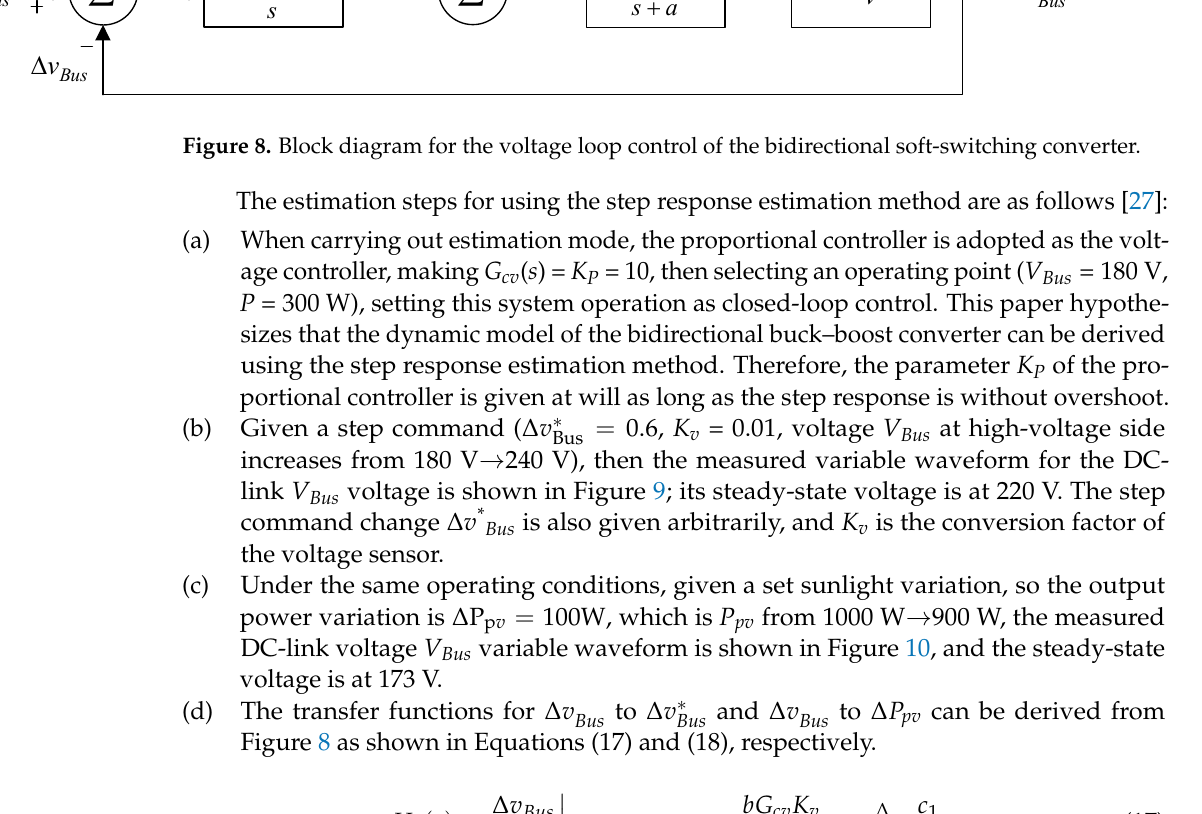
Figure 8. Block diagram for the voltage loop control of the bidirectional soft-switching converter.